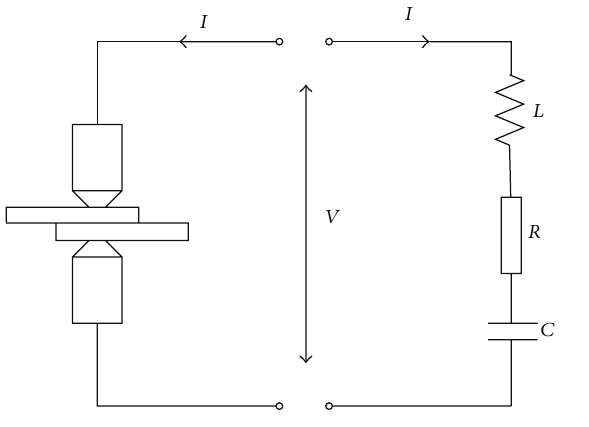
Figure 5: Ideal displacement